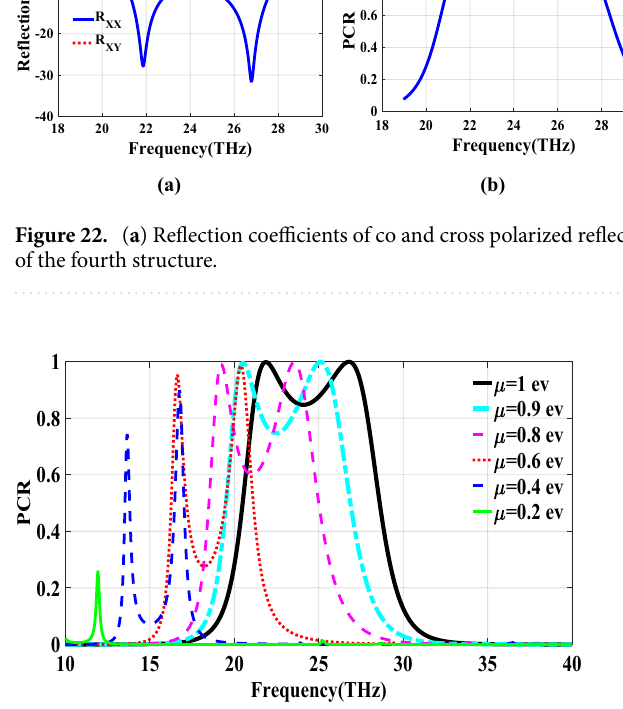
Figure 23. PCR of the fourth structure for different chemical potentials of graphene.